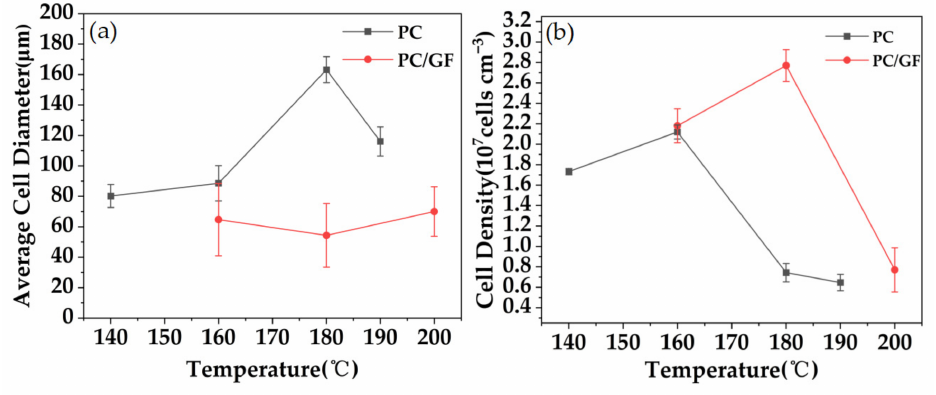
Figure 11. Pure PC and 15% GF loaded PC/GF at different foaming temperatures: ( a ) changes in mean cell diameter and ( b ) changes in cell